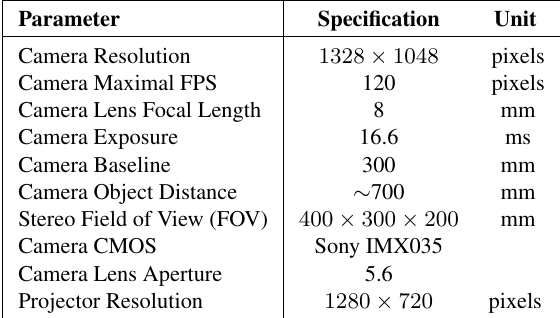
Table 1. Technical specifications of our mobile structured light